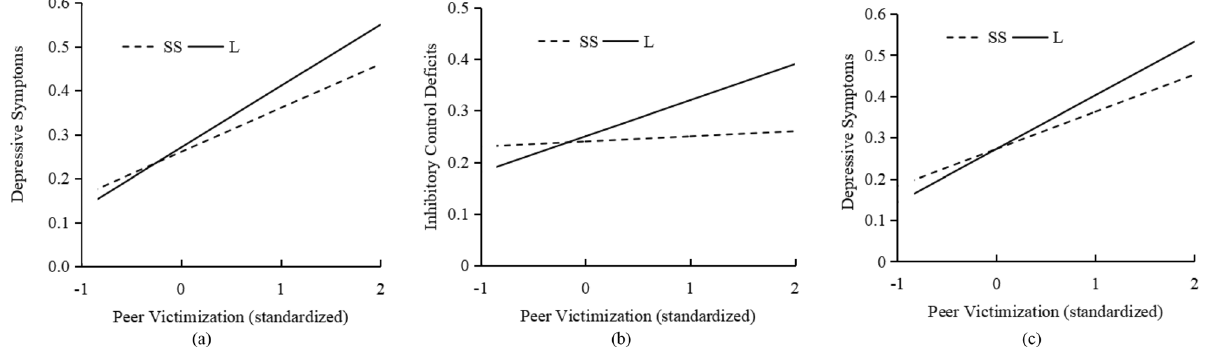
Figure 1. Graphical plots of interaction between peer victimization and 5-HTTLPR in the prediction of depressive symptoms ( a ), inhibitory control deficits ( b ), and depressive symptoms (when added inhibitory control deficits to model as a mediated variable) ( c ). Solid line , L allele carriers; Dash line, SS homozygotes